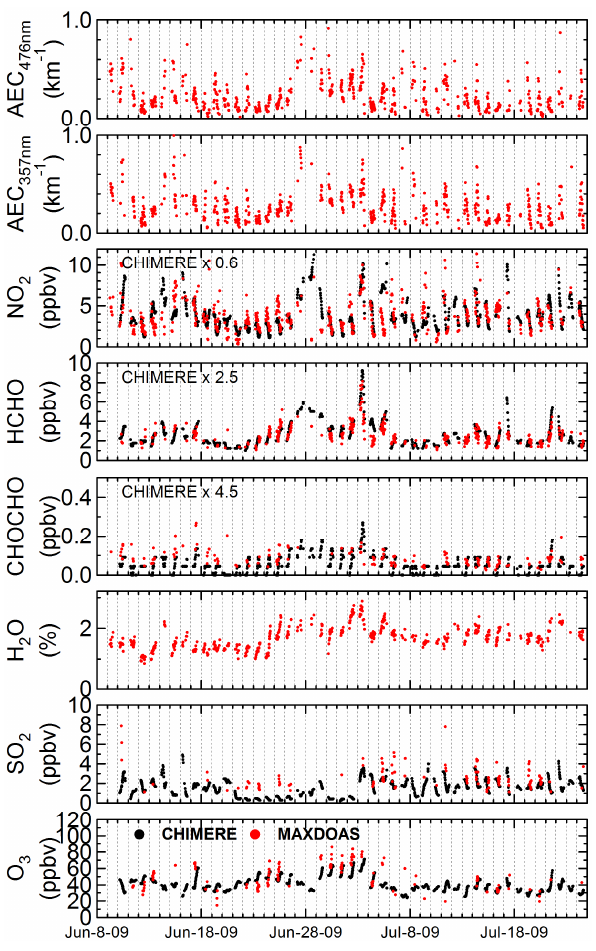
Fig. 5. Time series of the 8 components retrieved from MAX- DOAS observations (red) for the 0–1km layer. Also shown in black are values calculated by the CHIMERE model. CHIMERE NO 2 , HCHO, and CHOCHO are scaled by factors of 0.6, 2.5, and 4.5, respectively, to improve agreement (see the text for more